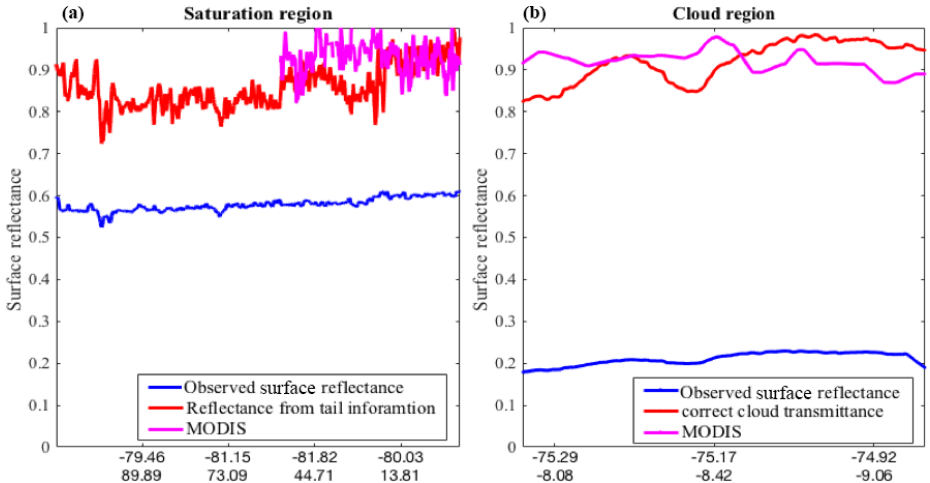
Figure 8. (a) CALIOP observed surface bidirectional reflectance (blue) and corrected surface bidirectional reflectance (red) corresponding to the saturated region of Fig. 6. (b) CALIOP observed surface bidirectional reflectance under transparent cloud before (blue) and after (red) correcting for the two-way transmittance of overlying clouds, corresponding to the unsaturated region of Fig. 6. The magenta lines show MODIS surface reflectance at 555nm.